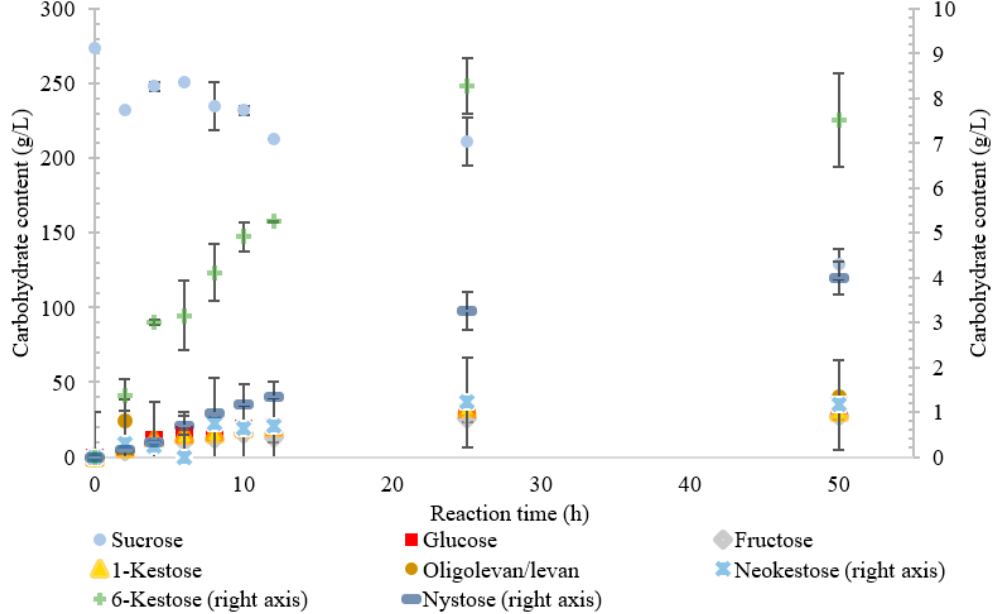
Figure 4. Reaction product profile of LS from Novosphingobium aromaticivorans with sucrose for 50 h at 30 °C.